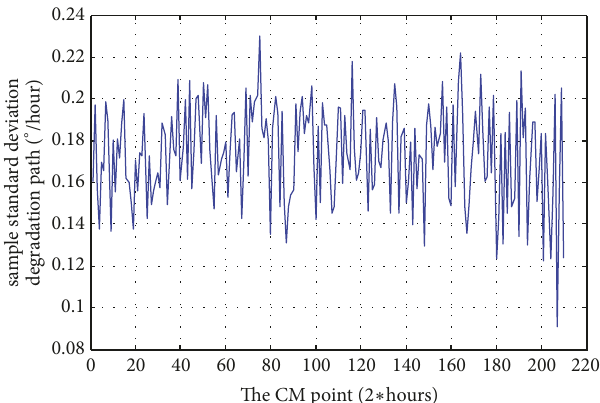
Figure 4: The sample mean of the gyro